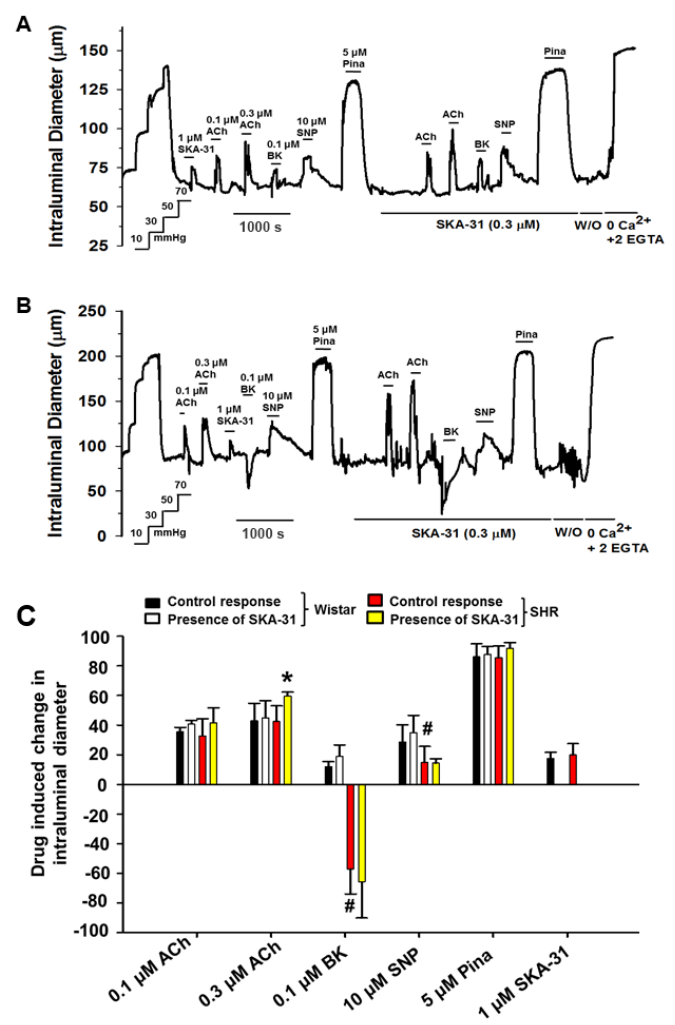
Figure 2. Treatment of cremaster skeletal muscle arteries from Wistar rats ( A ) and SHRs ( B ) with SKA-31 has minimal e ff ect on endothelium-dependent vasodilation. The representative tracing in panel A depicts vasodilatory responses evoked by bath application of acetylcholine (ACh, 0.1 and 0.3 µ M), bradykinin (BK, 0.1 µ M), sodium nitroprusside (SNP, 10 µ M) and pinacidil (Pina, 5 µ M) in a myogenically constricted cremaster artery from a Wistar rat, in the absence and presence of 0.3 µ M SKA-31, as indicated by the horizontal bars above and below the tracing. Panel B displays vasoactive responses to the same agents in a myogenically constricted cremaster artery from a SHR. The summary data in panel ( C) display the percent change in intraluminal diameter evoked by ACh, BK, SNP, and Pina in the absence and presence of SKA-31. Data are plotted as means ± S.D., with n = 3–4 animals for each experimental condition. The hashtag symbol (#) indicates a statistically significant di ff erence in the magnitude of the vasoactive response compared with the control condition (Wistar), as determined by one-way ANOVA and a Tukey’s post-hoc test, p < 0.05. The asterisk (*) denotes a statistically significant di ff erence vs. responses in the absence of SKA-31 exposure, as determined by a paired Student’s t-test, p <